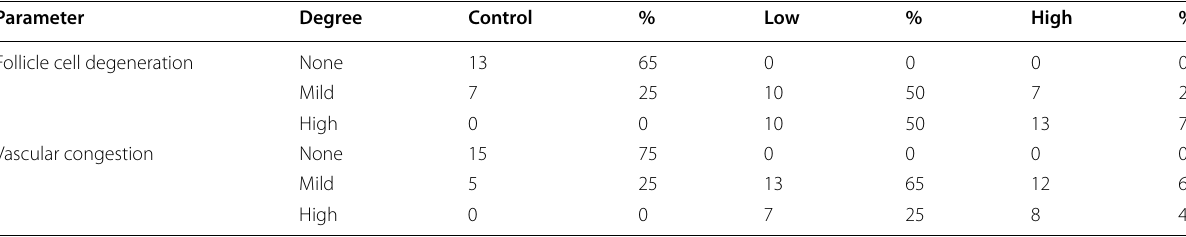
Table 7 Uterine tissue morphometric changes between study groups